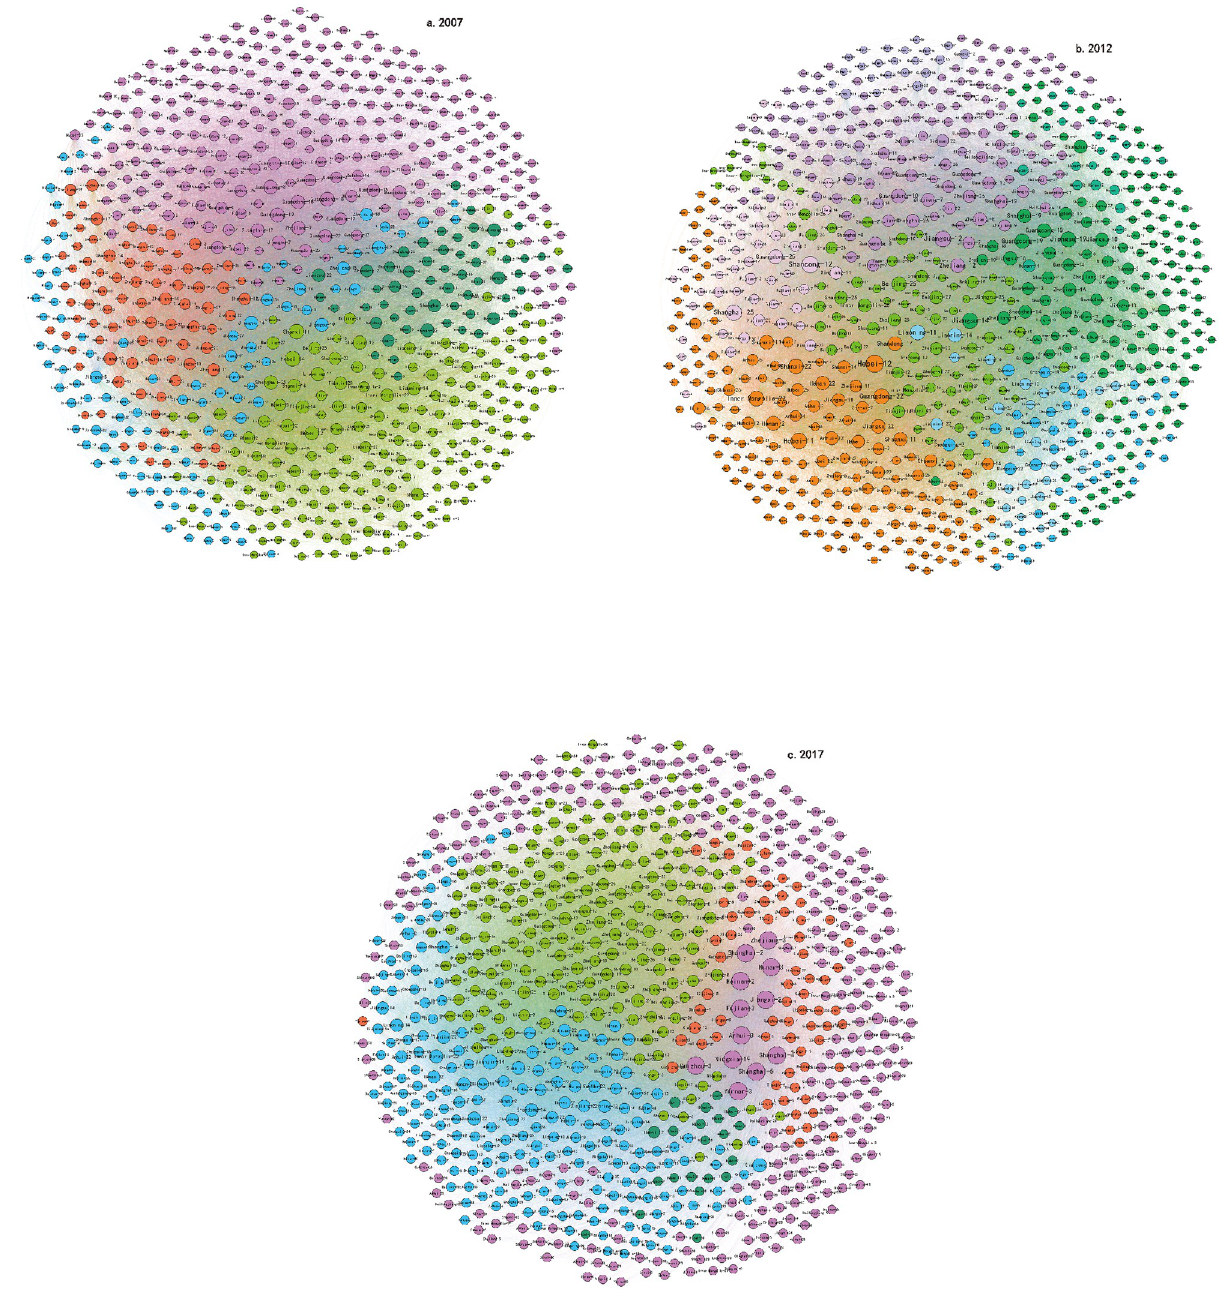
Fig 2. Community division of embodied CO 2 flow network results of China’s exports in 2007, 2012 and 2017.